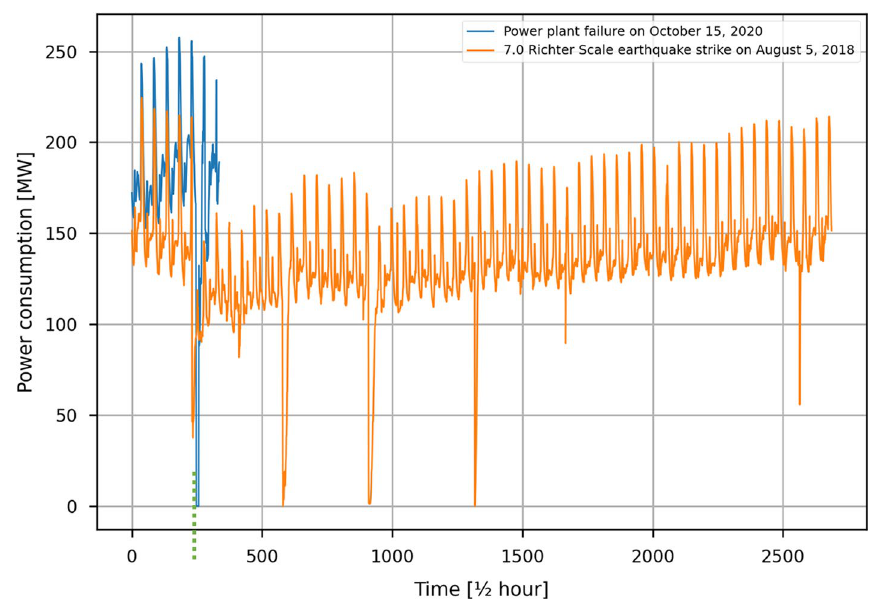
Fig. 31 Comparison of power consumption developments following disruption events. The green dashed line indicates the unfolding of the disruption events. The starting point of the graphs are 5 days prior to the exact disruption